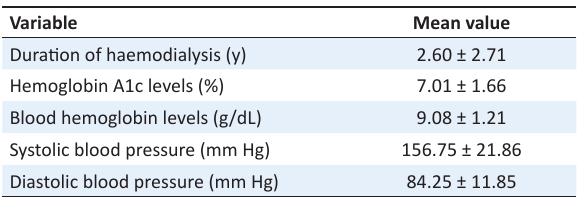
Table 1. Clinical variables of these patients